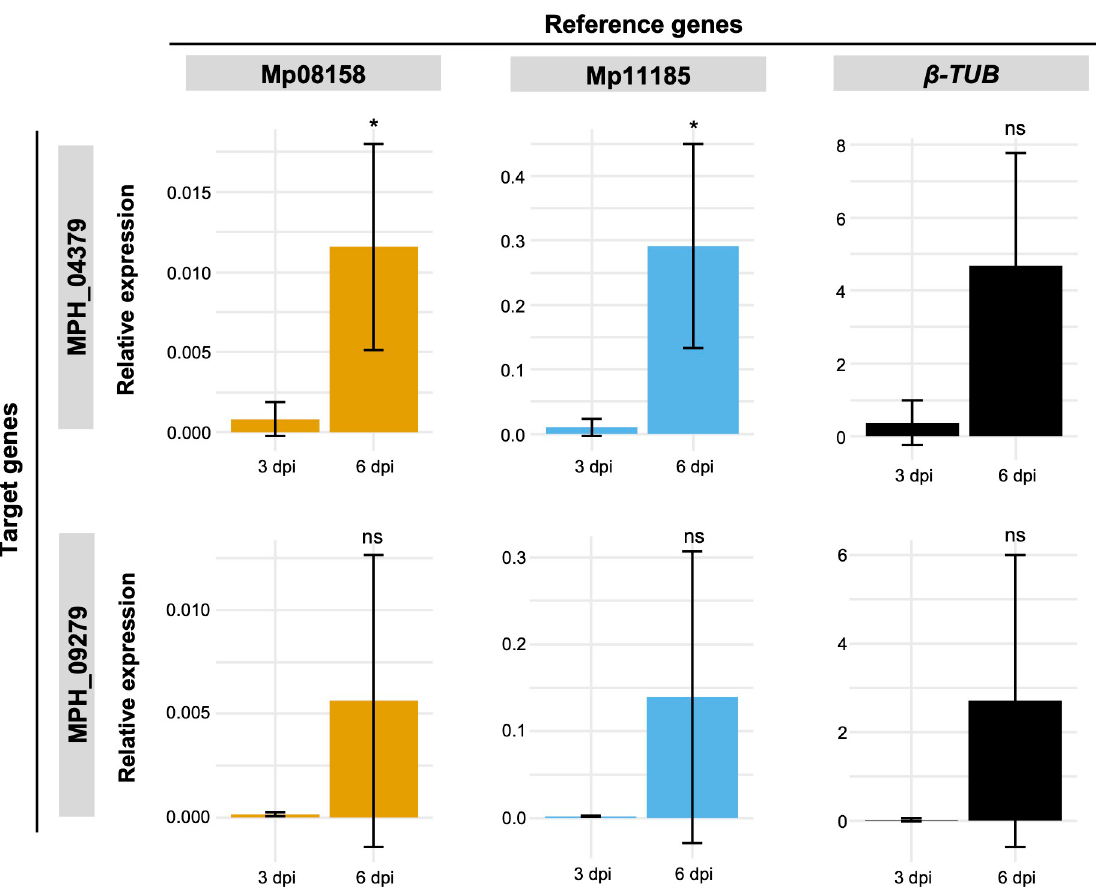
Fig 5. Expression of two cutinase genes of M . phaseolina during soybean stem infection. Expression analysis of cutinase genes MPH_04379 (top) and MPH_09279 (bottom) was performed to validate the reference genes. RNA was extracted from soybean stem infected with M . phaseolina isolate Nar at 3 and 6 dpi. Mp08158 (left) and Mp11185 (middle) were used as recommended internal controls, and β -TUB (right) was used as worst internal control. Data are mean ± standard deviation of at least three biological replicates. Student’s t - test was applied where � P < 0.05 and ns: not